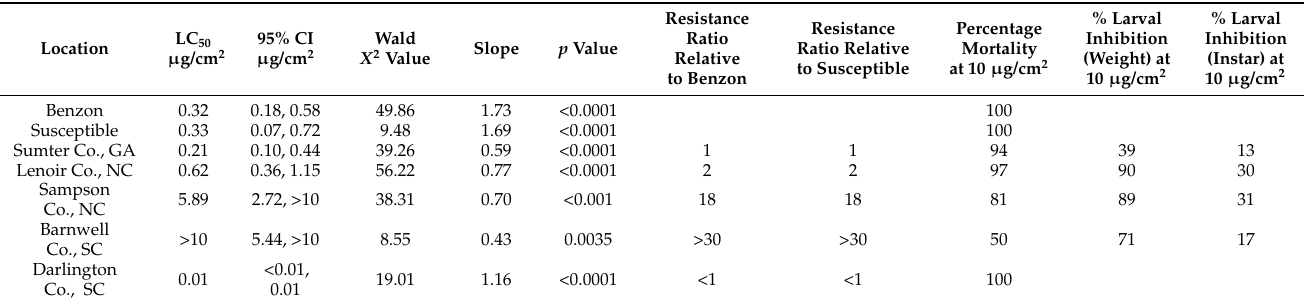
Table 1. Bioassay results for Cry1Ac,